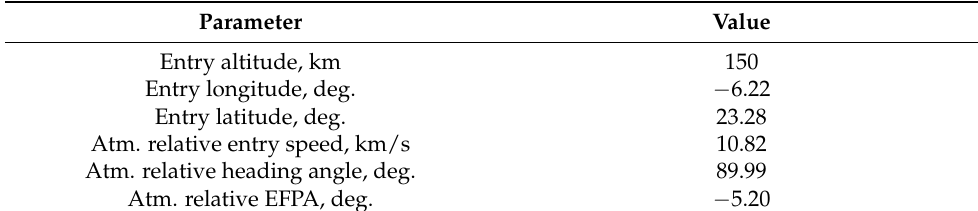
Table 7. Venus aerocapture vehicle atmospheric entry state.